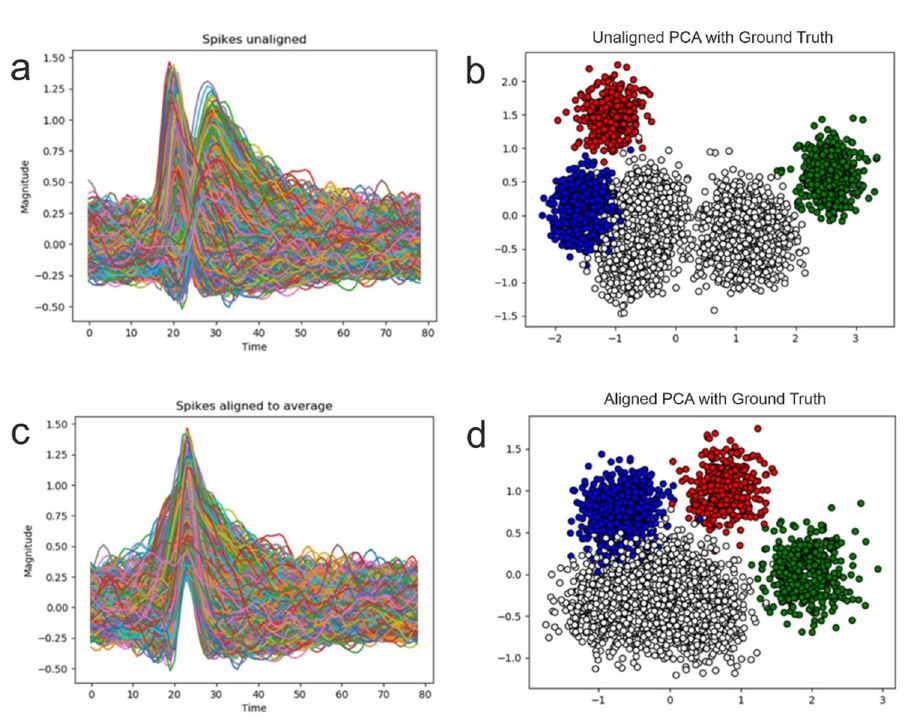
Fig 4. Impact of alignment. PCA applied on Sim14 with and without alignment. The white cluster is kept together but the overlap with the blue cluster